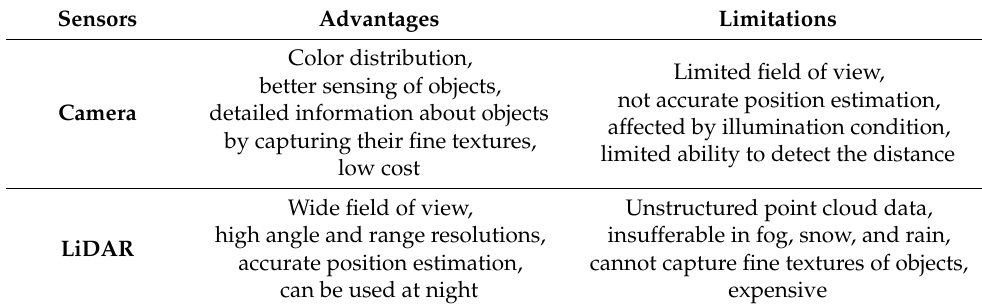
Table 7. Comparison of Camera and LiDAR Sensors.